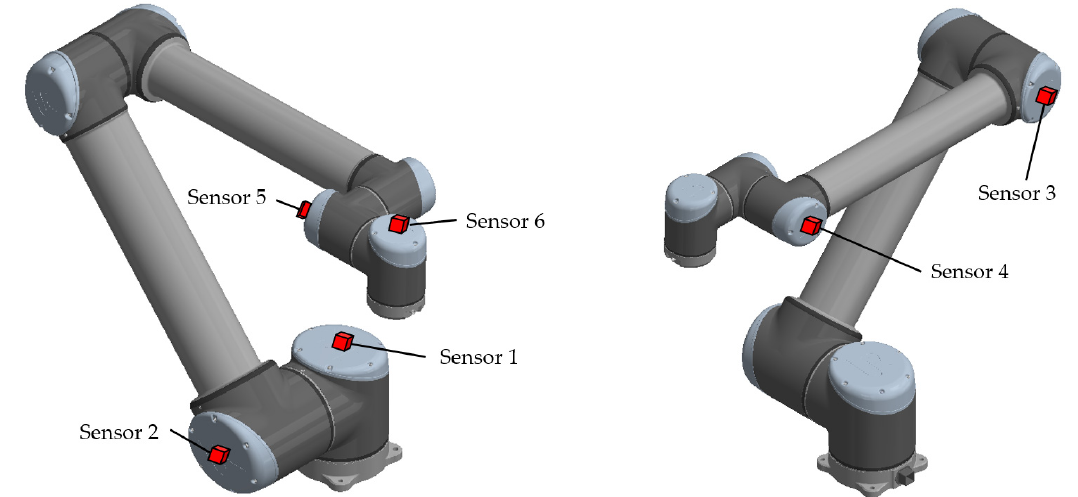
Figure 3. Location of sensors for vibration measurement.